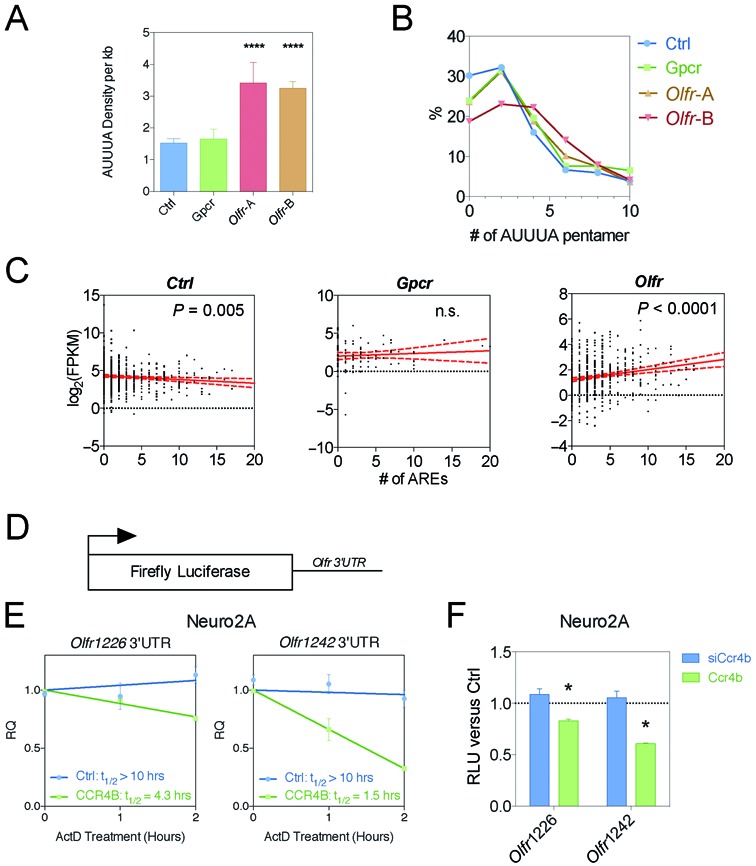
Olfr mRNAs are ARE-rich. (A) ARE pentamer density measured in silico. (B) Density distribution plot of the number of AUUUA ARE pentamers, assessed as in panel (A). (C) Scatterplots and linear regression analysis of expression level versus AUUUA pentamer density, assessed as in panel A. (D) Schematic of luciferase and renilla reporters used. (E,F) Two Olfr 3′ UTRs influence mRNA steady-state level and mRNA half-life in response to CCR4B depletion (using a siRNA targeting CCR4B [siCcr4b]) and CCR4B overexpression (using a CCR4B expression vector). Panel E is measurement of relative mRNA levels (RQ) and panel (F) is measurement of relative luciferase values (RLU). *P < 0.05; n.s. not significant.